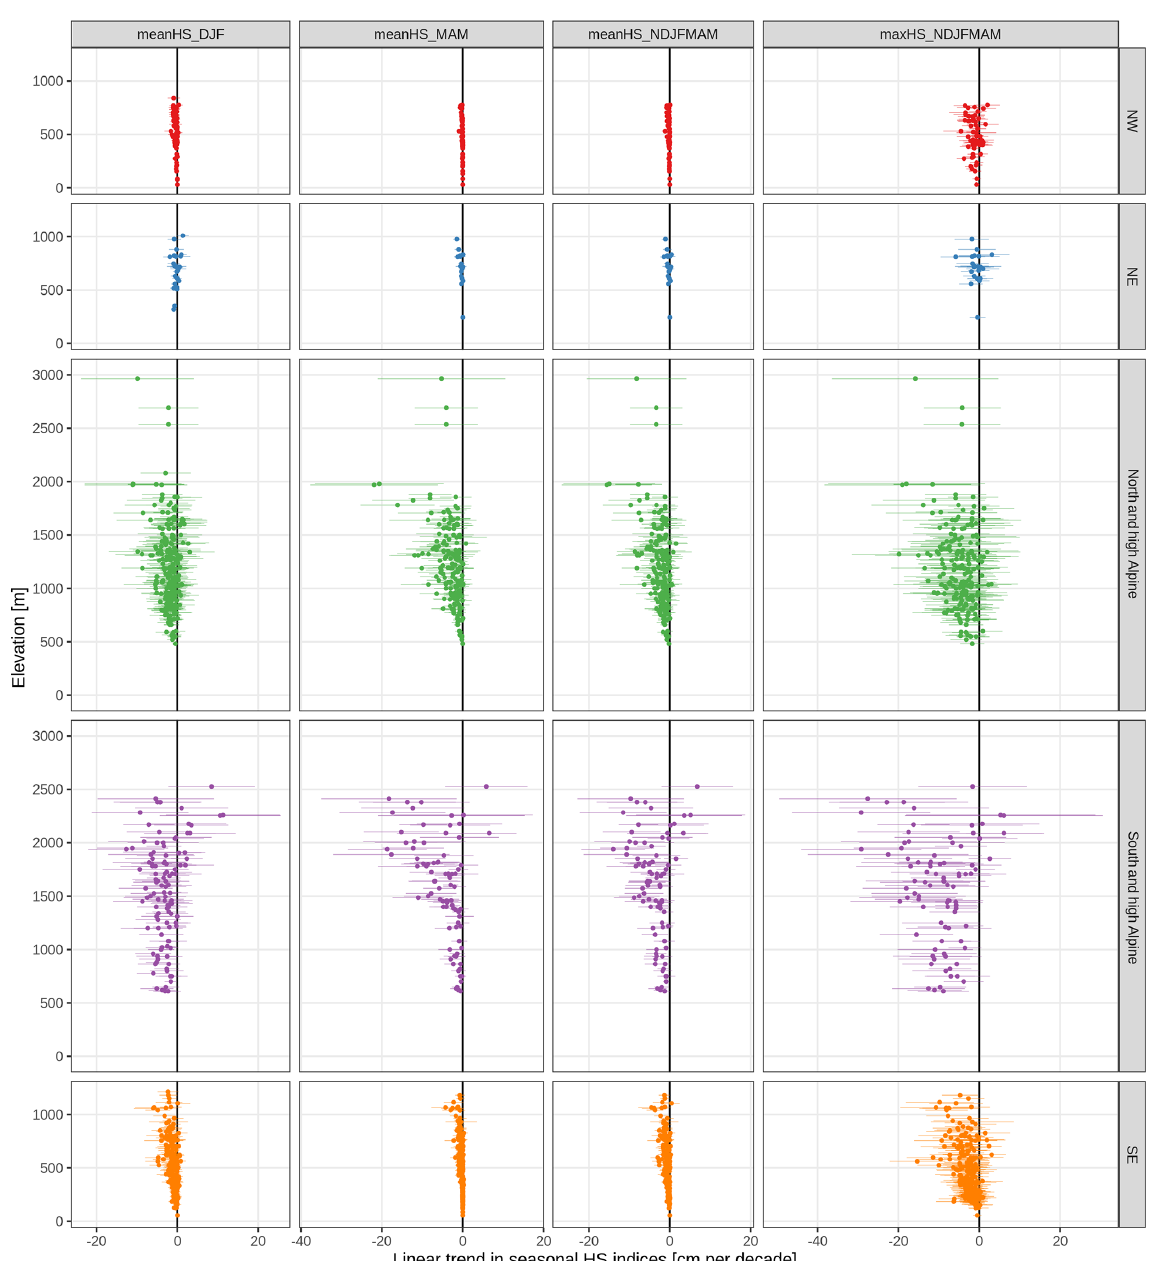
Figure C1. Long-term (1971 to 2019) linear trends in seasonal snow depth (HS) indices. Trends are shown separately by index (columns) and region (rows). The season is indicated in the columns with the first letter of the included months (e.g. DFJ is December, January, and February). Each point is one station. The points indicate the trend and the lines the associated 95% confidence